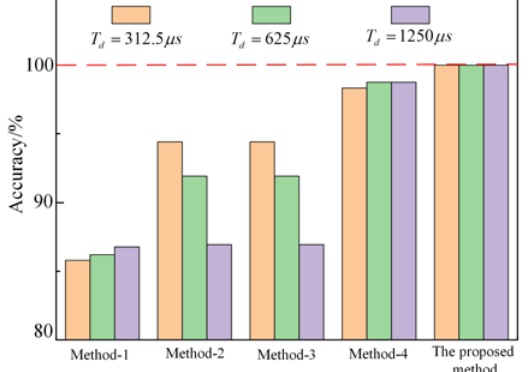
Figure 16. Test results of different methods undersampling delay.